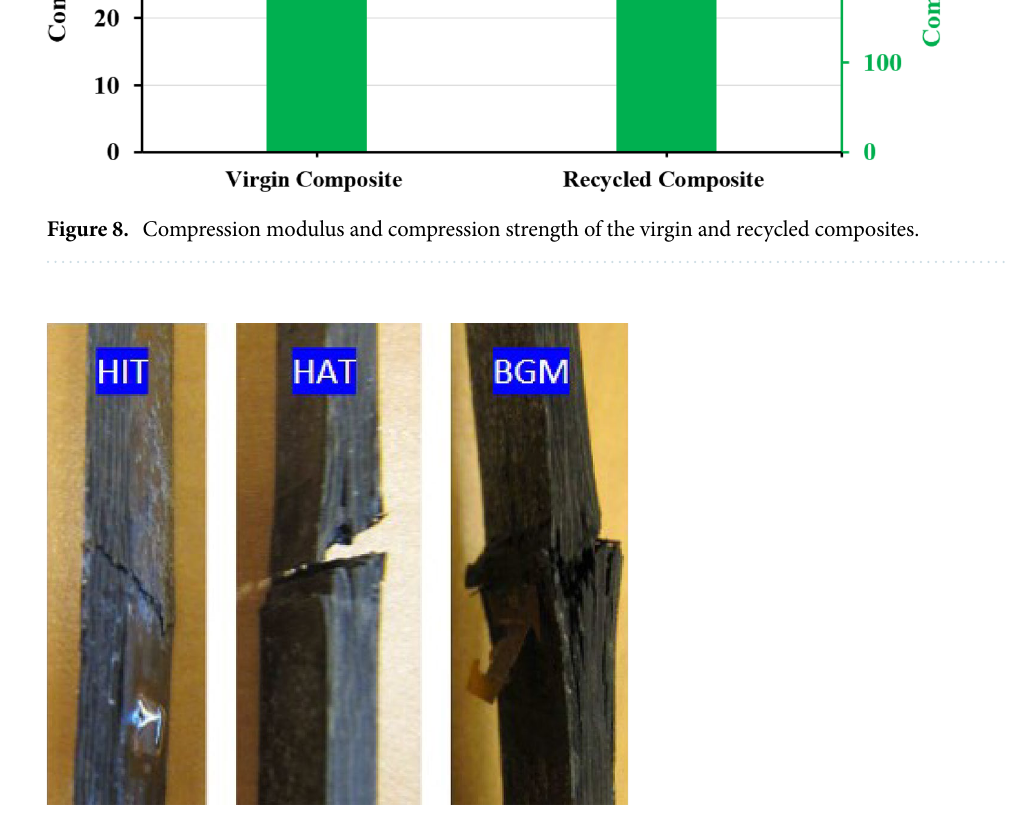
Figure 9. Failure modes observed in the recycled specimens: HIT failure mode, HAT failure mode and BGM failure